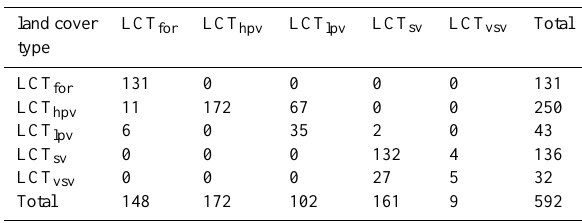
Fig. 6. Comparison of GLC2000, PFT 2001, decision tree classifi- cation result of 2001 and Landsat 7 ETM+ (up: bands 4-3-2., down: bands 5-4-1., measured: 20 January 2001). Up: Entire study region. Below: Zoom to Casablanca region (A- City of Mohammedia, B- City of Casablanca, C-Forest of Bouskoura, D-Airport ’Mohammed V’). Table 2. Confusion matrix of decision tree classification result of 2004 using ground truth information from the administrative re- gion of Grand Casablanca. Columns show the ground truth pixels of land cover types and rows show the classified land cover types for these pixels: LCT for (Forest), LCT hpv (High-productive vegeta- tion), LCT lpv (Low-productive vegetation), LCT sv (Sparsely vege- tated), LCT vsv (Very sparsely